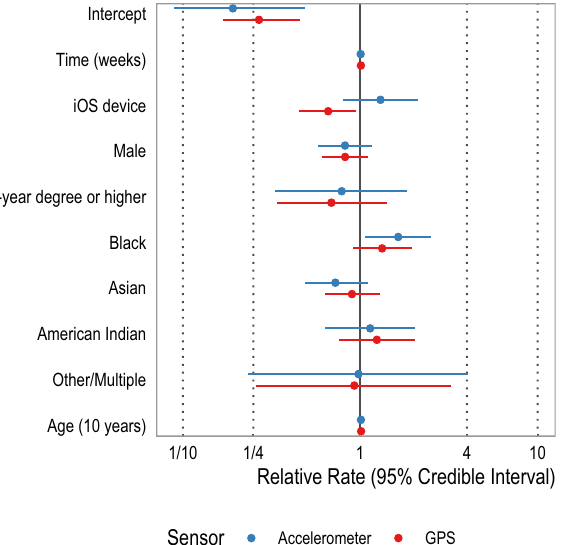
Figure 3. A forest plot of fixed effect estimates. The fixed effect estimates for accelerometer are in red and GPS in blue. Estimates have been exponentiated and can be interpreted as the relative change in sensor non- collection. The reference group for education is less than 4-year college degree and for race/ethnicity is non- Hispanic White. In terms of demographic characteristics, Black participants had higher rates of accelerometer non-collection compared to White participants; Asian participants had lower rates of accelerometer non- collection compared to White participants. iOS users had lower rates of GPS non-collection but higher rates of accelerometer non-collection, suggesting systematic differences in the phone operating systems of each